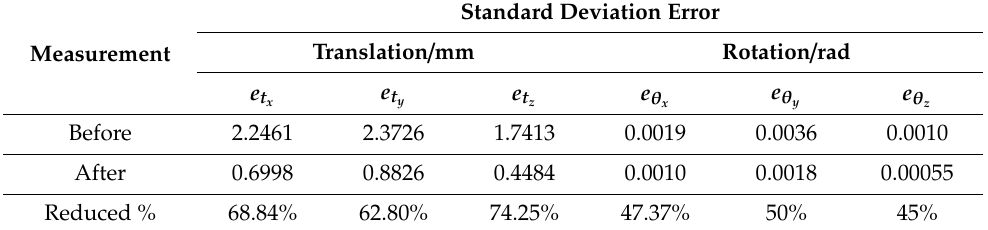
Table 6. Standard deviation error.